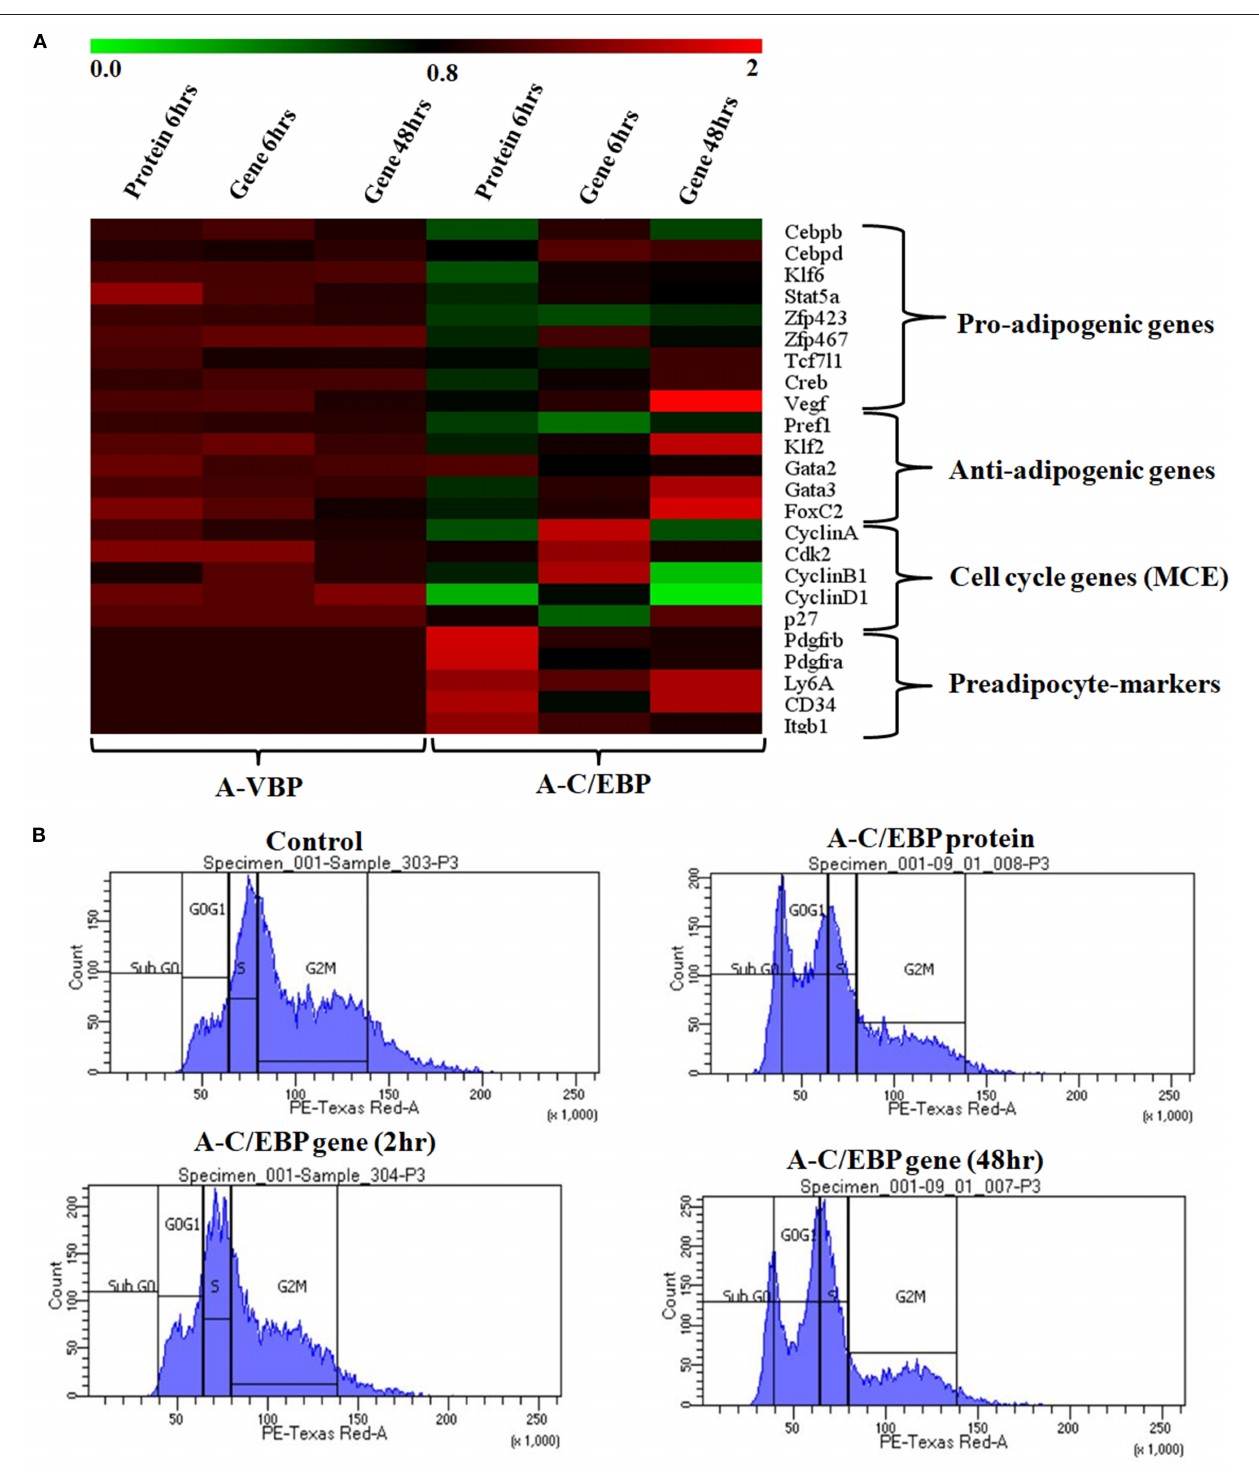
FIGURE 4 | Effects of A-C/EBP and A-VBP protein and gene transfections at the indicated conditions on the expression of factors involved in adipogenesis, MCE, and preadipocyte state of 3T3-L1 cells and flow cytometry analysis. (A) Heat map representing real-time PCR analyses of the expression of 24 genes involved in the process of differentiation, MCE, and preadipocyte markers from the cells transfected with A-C/EBP and A-VBP protein and gene. The color indicates the fold-change value converted to log2 scale, as compared with untreated sample. The data represent the mean of six independent biological experiments, and transcript was normalized to actin. (B) Effect of A-C/EBP on change in cell cycle stages of transfected and differentiated cells analyzed by flow cytometry and plotted on a graph.